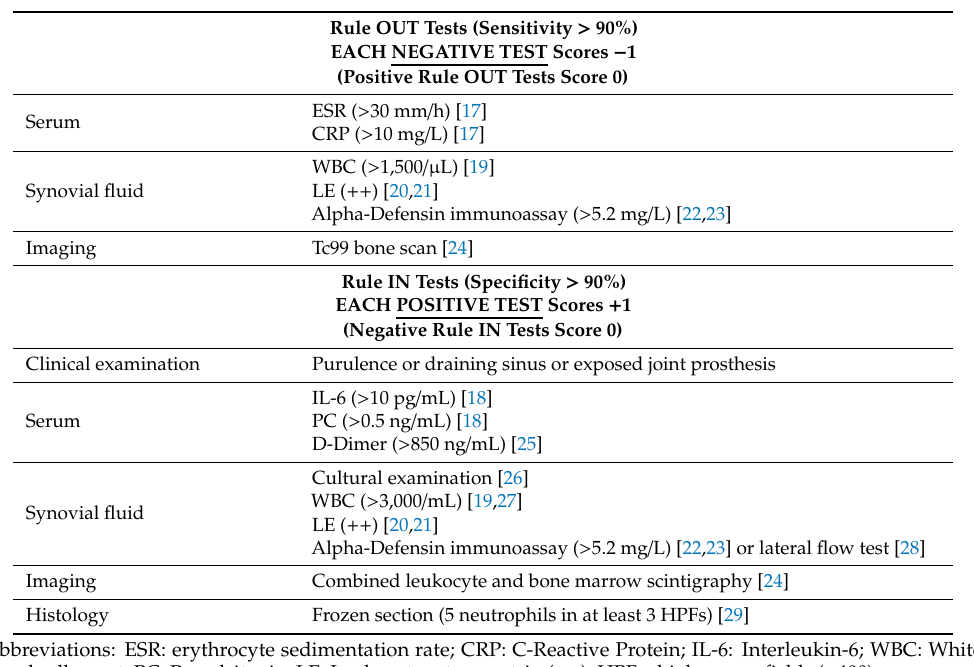
Table 2. Pre- and intra-operative tests, classified according to their sensitivity and specificity and hence their ability to exclude (“Rule OUT”) or to confirm (“Rule IN”) a PJI. In parenthesis, the reference cut-o ff value considered